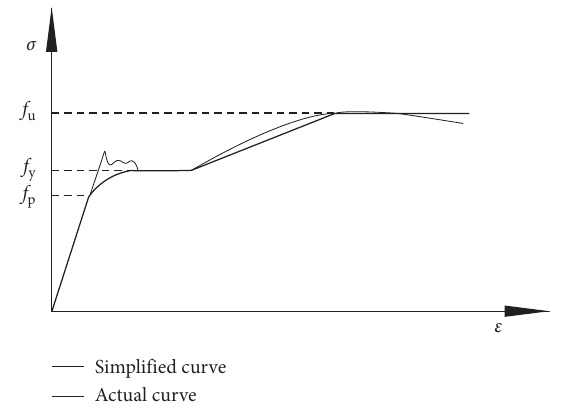
Figure 2: Stress-strain curve of cold formed